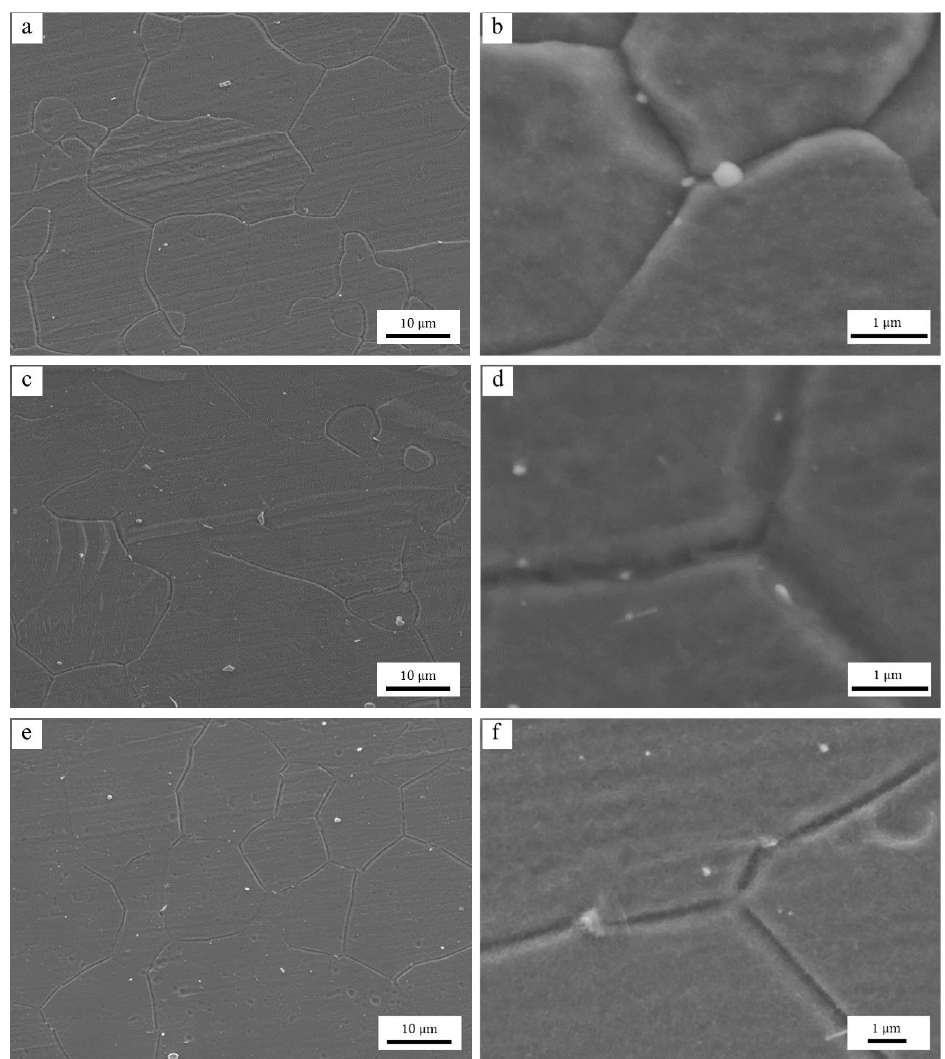
Figure 11. SEM images of AZ31 annealed at ( a , b ) 300 °C, ( c , d ) 350 °C, and ( e , f ) 400 °C for 72 h. In fact, the morphology of the second phase particles in AZ Mg alloys can be quite complex, ranging from granular to rod-like and network-like morphology [30 – 32]. At pre- sent, there are few reports on lamellar second phase particles in AZ Mg alloys. The pin- ning effect depends on the interaction between the second phase particles and grain boundaries. The morphology of the second phase particles leads to different contact pat- terns between the second phase particles and the grain boundaries. Thus, different mor- phologies of second phase particles have different pinning effects on grain boundaries. Previous studies have shown that deviations of the aspect ratio of second phase particles from 1 lead to an increase in the pinning effect [9,33]. This means that the lamellar second phase particles have a stronger pinning effect on the grain boundaries than the rod and granular forms.